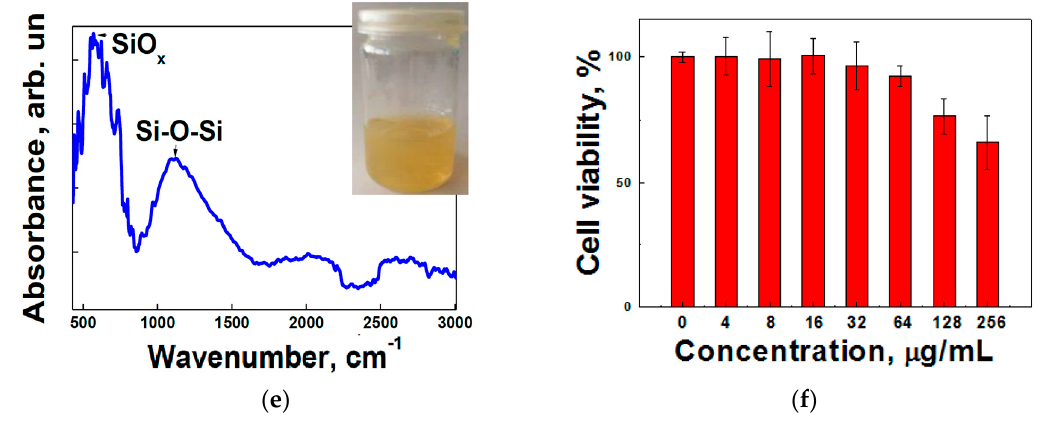
Figure 1. ( a ) Cross-sectional scanning electron microscope (SEM) image of a silicon-nanowire (SiNW) array on crystalline silicon (c-Si) substrate; ( b ) cross-sectional SEM image of SiNWs; ( c ) transmission electron microscopy (TEM) image of silicon nanoparticles (SiNPs) and inset with electron diffraction pattern of SiNPs; ( d ) Dynamic light scattering (DLS) size distribution function of SiNPs; ( e ) Fourier-transform infrared (FTIR) spectrum of SiNPs and inset with digital image of an aqueous suspension with SiNP concentration of 0.25 mg/mL; and ( f ) viability of MCF-7 breast cancer cells vs. SiNP concentration.